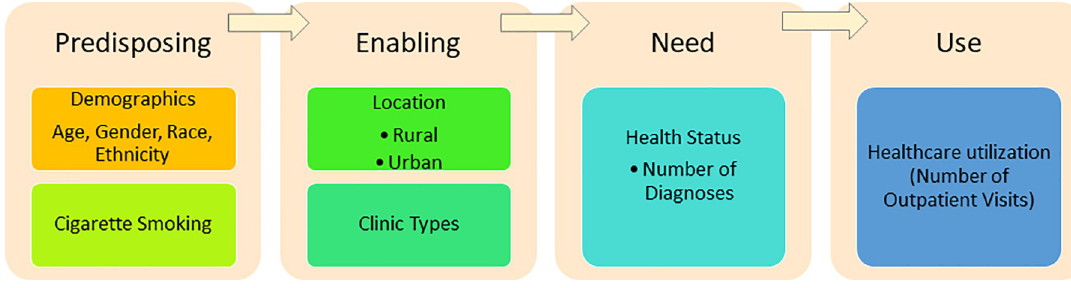
Fig 1. Adapted Andersen Behavioral Model of Health Services